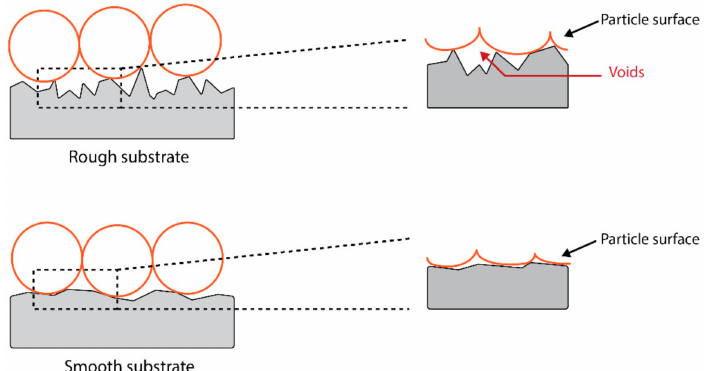
Figure 8. Comparison of the adhesion of particles on a rough surface and a smooth surface. The zoomed-in views show the formation of voids during the post–deposition processing, especially when the surface is